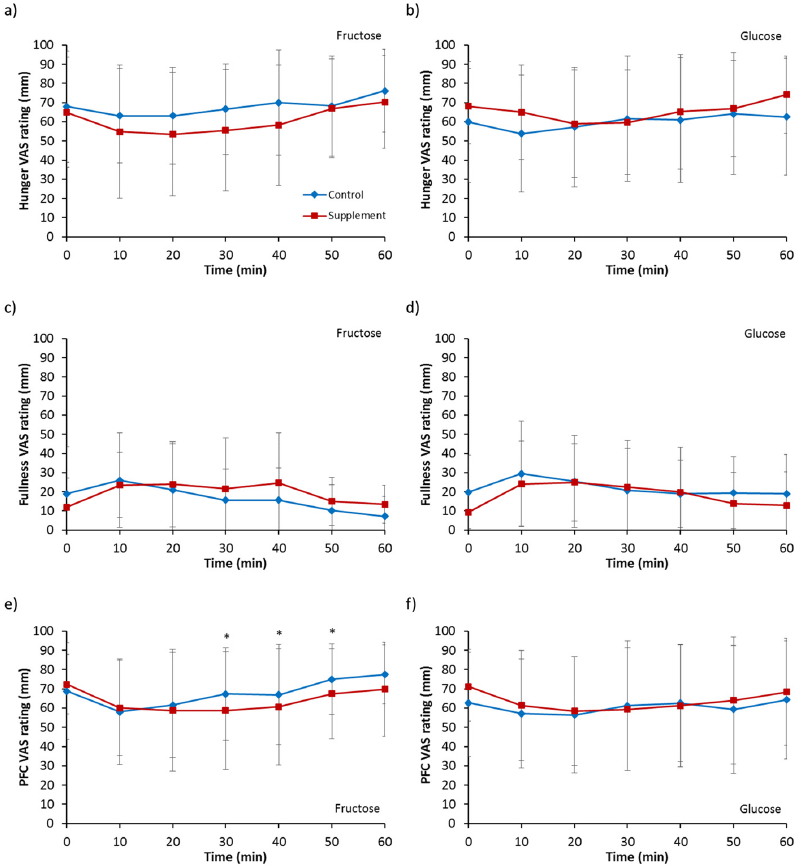
Figure 6. Visual analogue scale (VAS) appetite ratings of hunger following ingestion of ( a ) a 6% fructose solution and ( b ) a 6% glucose solution, ratings of fullness following ingestion of ( c ) a 6% fructose solution and ( d ) a 6% glucose solution, and ratings of prospective food consumption (PFC) following ingestion of ( e ) a 6% fructose solution and ( f ) a 6% glucose solution. Treatments were control without fructose supplementation and with three days of supplementation of 120 g fructose per day. * Significantly greater for control trial compared to supplement ( p < 0.05). Values are mean ± standard deviation.